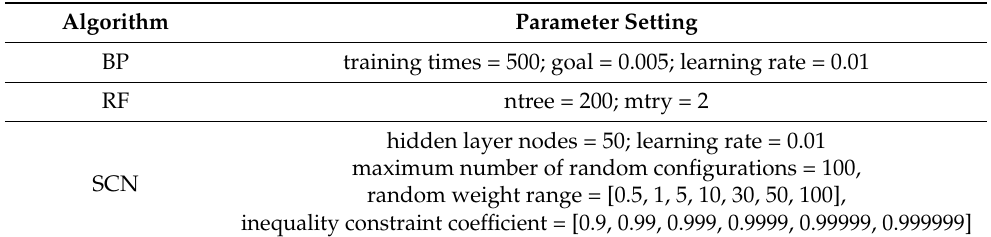
Table 4. Parameter setting of each algorithm.